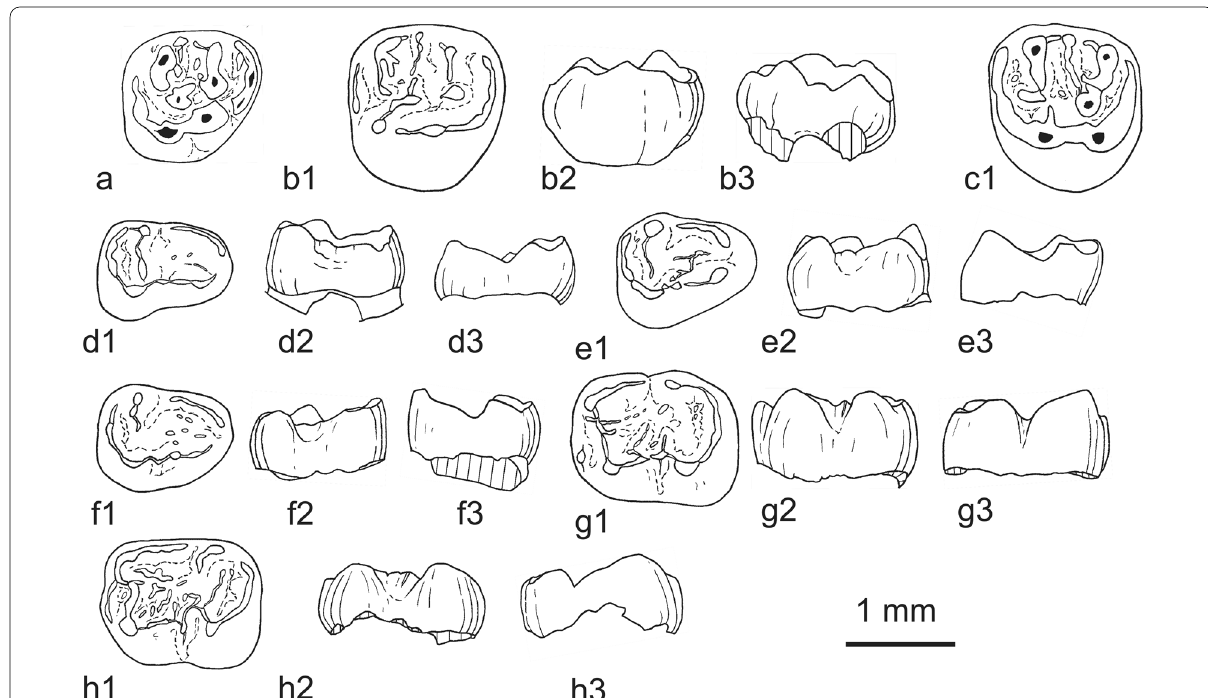
Fig. 50 Teeth of ? Protadelomys cf. maximini morphotype 2, from Saint‑Maximin (Gard). a SMX3‑44, right DP4; occlusal view. b SMX3‑45; right M1; b1, occlusal view; b2, lingual aspect; b3, buccal aspect. c : SMX3‑47, left M1; occlusal view. d SMX3‑40, right dp4; d1, occlusal view; d2, buccal aspect; d3, lingual aspect. e SMX3‑42, right dp4; e1, occlusal view; e2, buccal aspect; e3, lingual aspect. f SMX3‑41, right dp4; f1, occlusal view; f2, buccal aspect; f3, lingual aspect. g SMX1‑222, left m1; g1, occlusal view; g2, buccal aspect; g3, lingual aspect. h SMX1‑225, left m1; h1, occlusal view; h2, buccal aspect; h3, lingual aspect. Scale bar 1 =